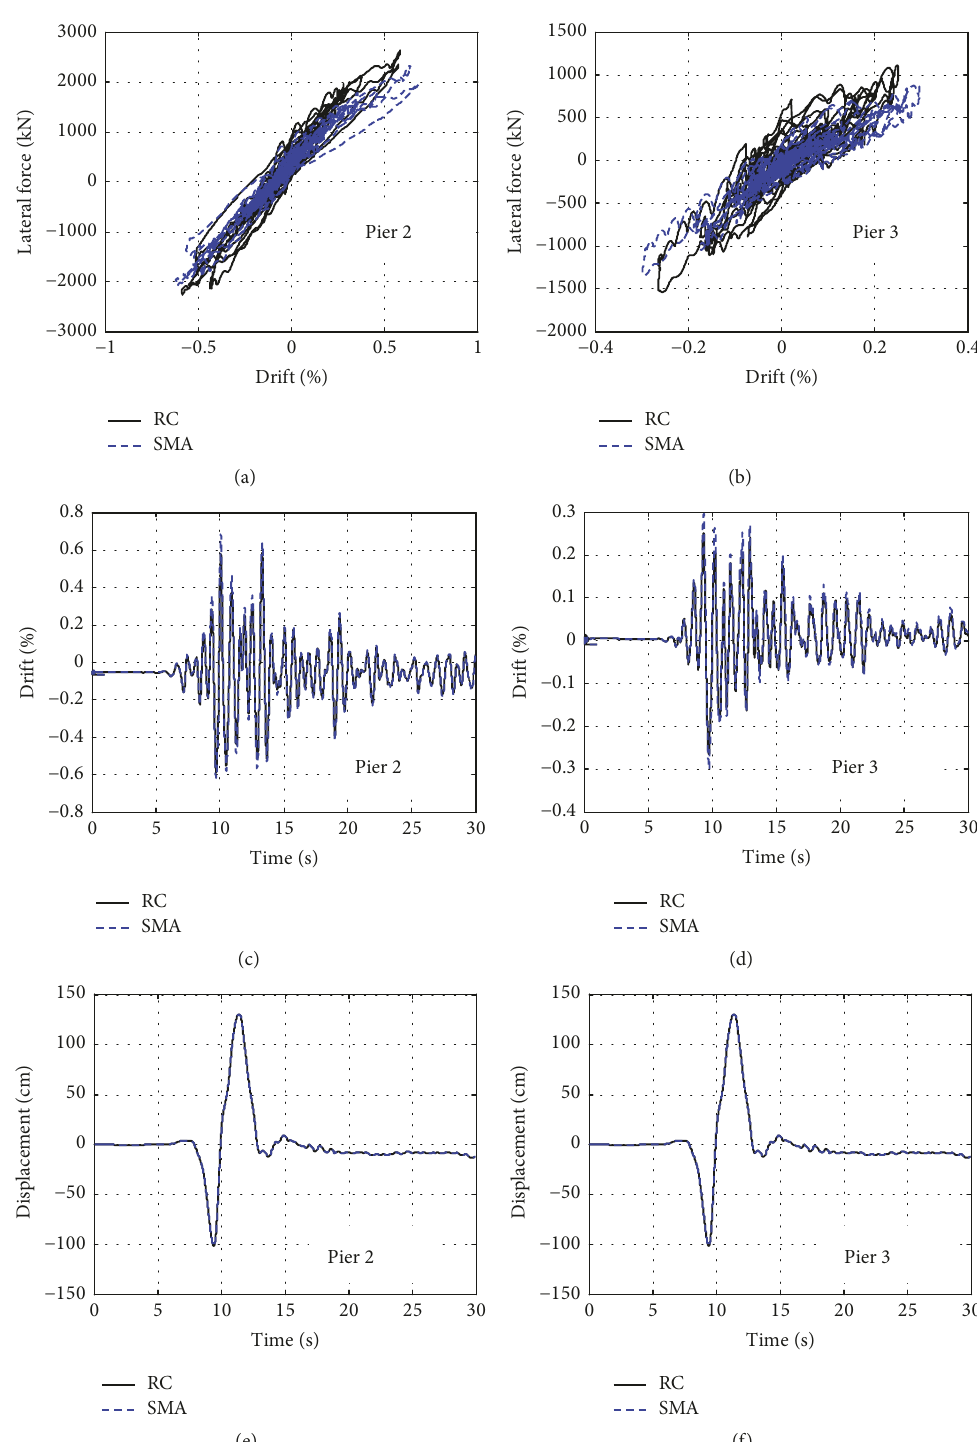
Figure 17: The response of Pier 2 and Pier 3 with double amplified motions: (a) and (b) base shear versus drift hysteresis curves; (c) and (d) relative drift of piers; (e) and (f) top displacement history of